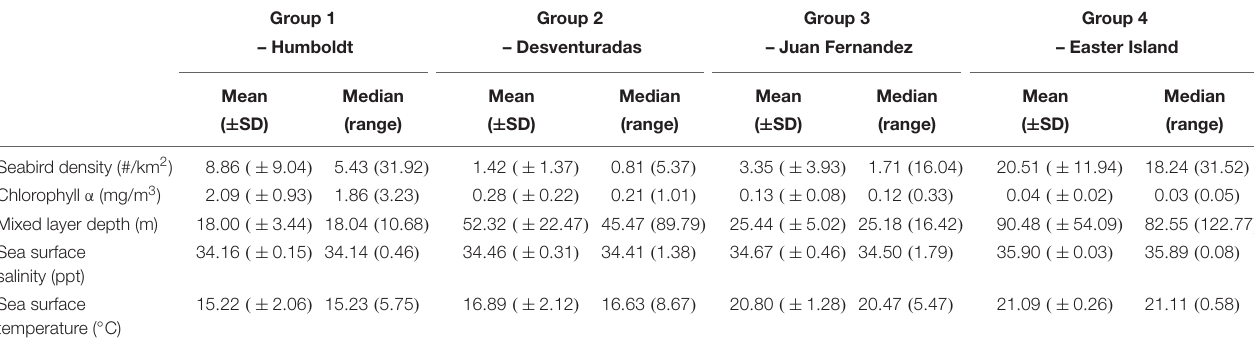
TABLE 4 | Oceanographic and biological characteristics of the biogeographic domains associated to the four cluster groups, defined by ocean productivity (seabird density of all species combined, chlorophyll α concentration, mixed layer depth), and surface water masses (temperature,